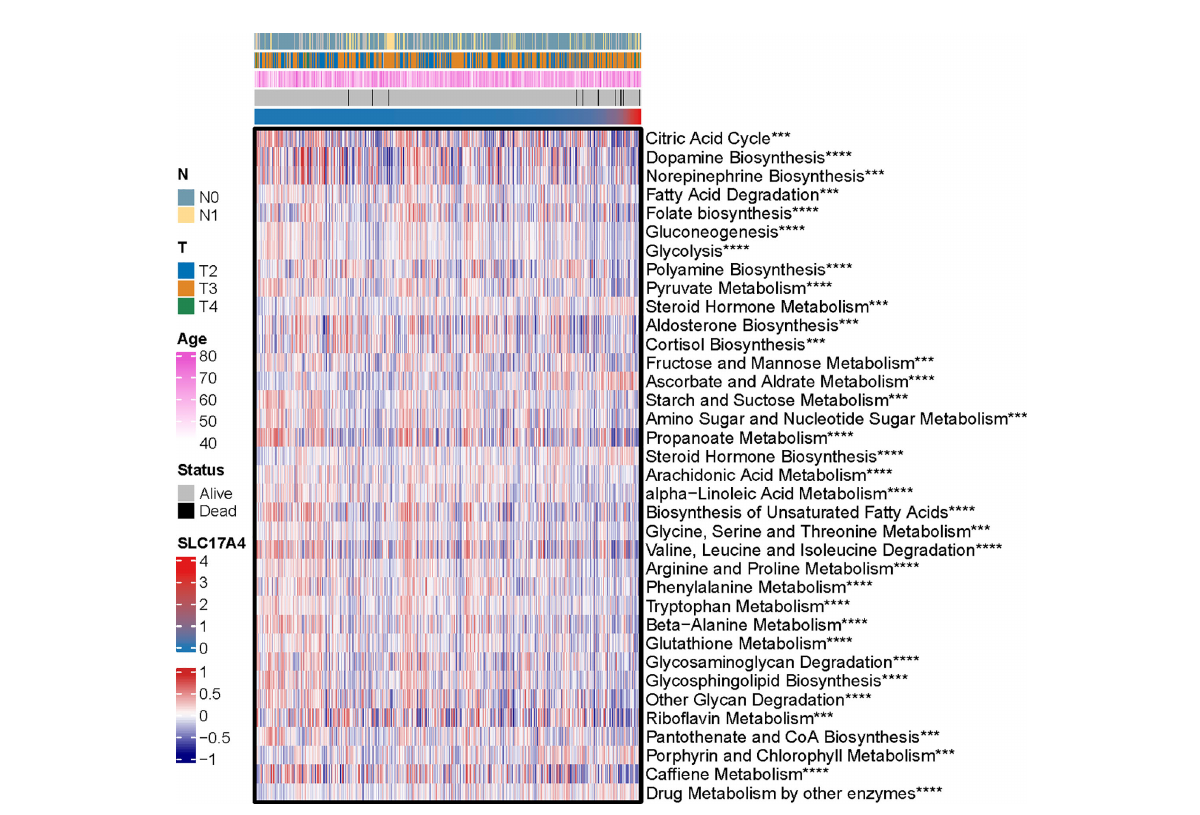
FIGURE 10 The correlation analysis between the 114 identi fi ed metabolic-related pathways and SLC17A4 (the most signi fi cant pathways was presented). ***p < 0.001, ****P <